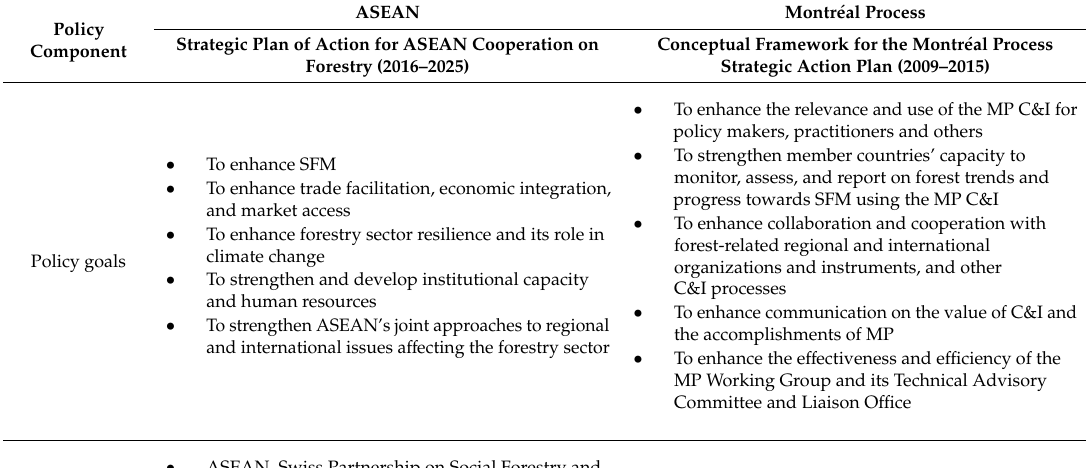
Table 4. Comparison of ASEAN and MP regional forest